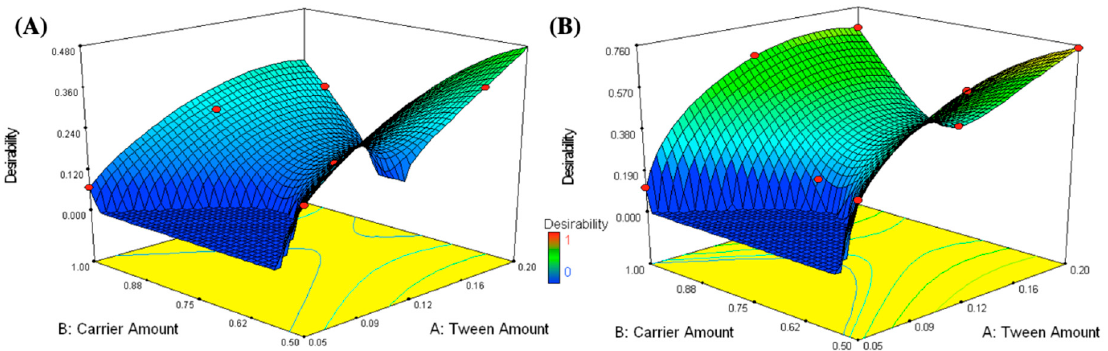
Figure 4. Response surface plots for the effects of T80 (X 1 ) and carrier amounts (X 2 ) on the desirability of the formulations loaded on different types of carriers (X 3 ); mannitol ( A ) and Aerosil ( B ).